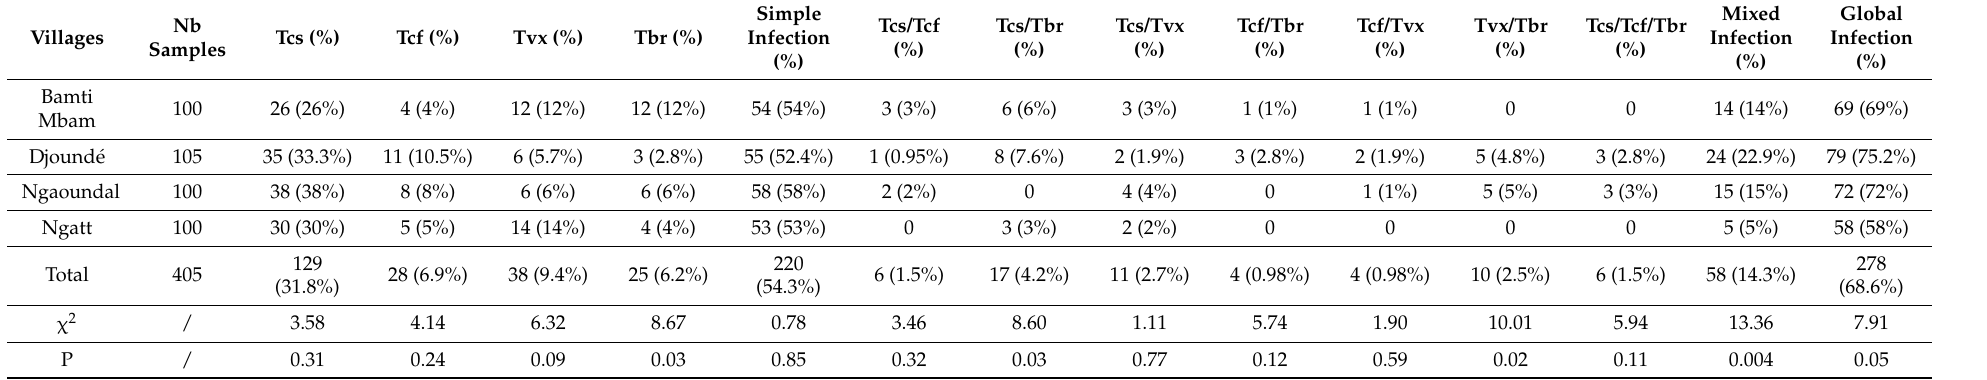
Table 2. Single, mixed, and global infection rates in cattle recorded using molecular (PCR) approach.